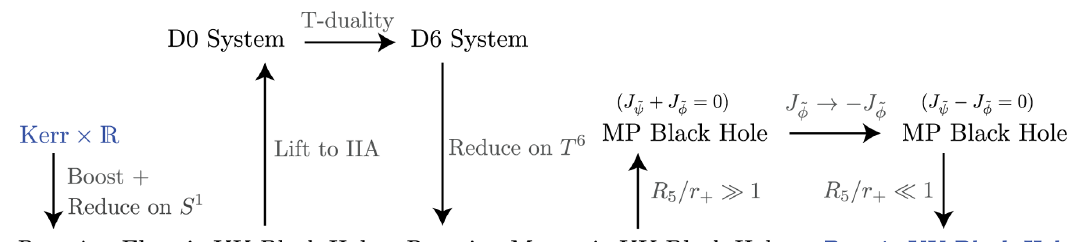
Figure 1 . Duality chain that maps the Kerr solution to a non-rotating dyonic Kaluza-Klein black hole. The start and endpoint of the chain are indicated in